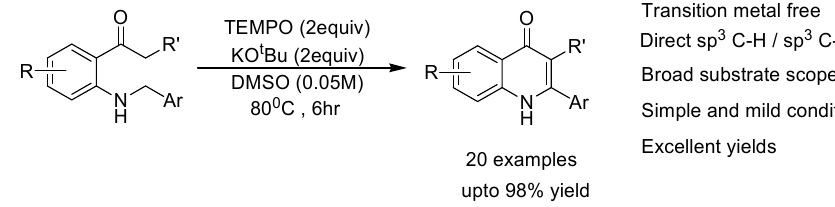
Scheme 1. Metal-free oxidative intermolecular Mannich reaction for the synthesis of 2-arylquinone- 4(1 H )-ones from secondary amines and ketones [6].